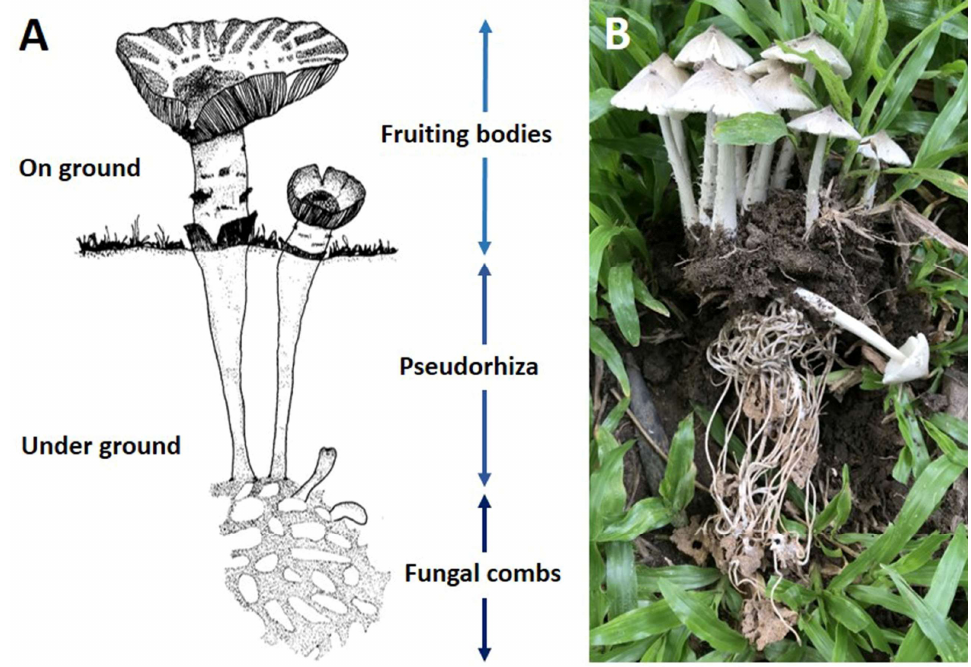
Figure 1. Illustration ( A ) and field photograph ( B ) of fruitbodies of the Termitomyces with different parts. Photo credit: Paloi, S. and Kumla, J.